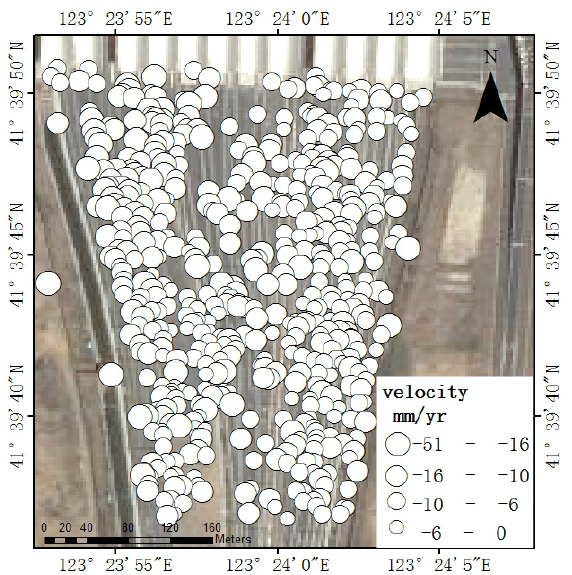
Figure.3(a) Subsidence pattern to the south of Shenyang South Railway Station in the western